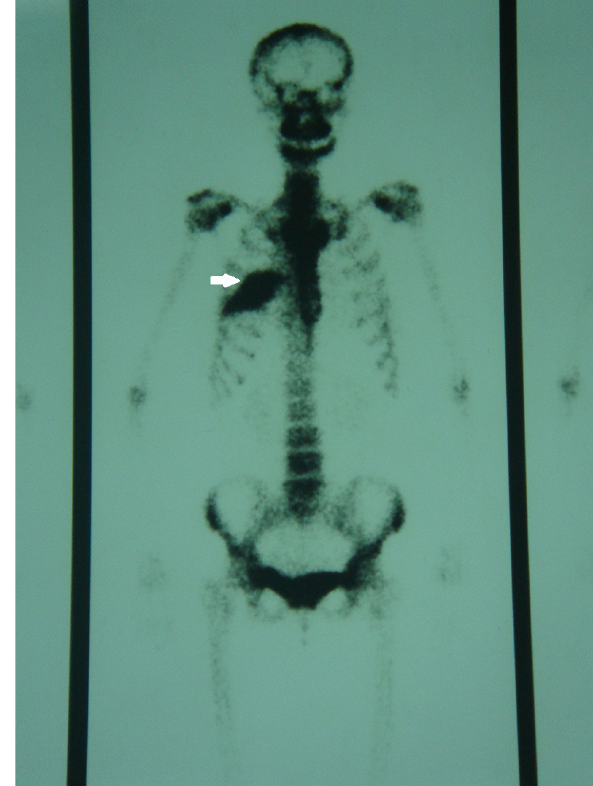
Figure 3: Emission Computed Tomography showed radionuclide uptake on the right seventh posterior rib (arrow).